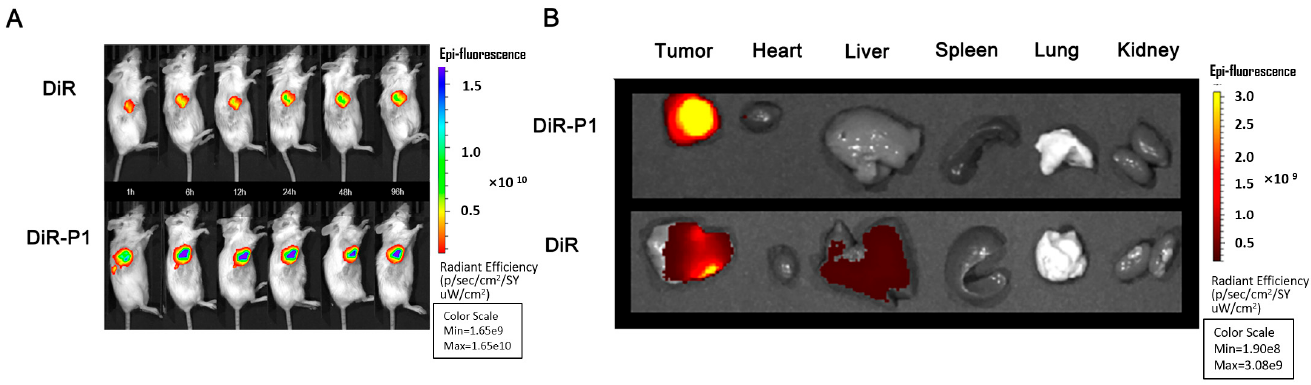
Figure 5. ( A ) In vivo fluorescence imaging of mice over time after administration. ( B ) Fluorescence imaging of tumors, hearts, livers, spleens, lungs, and kidneys of